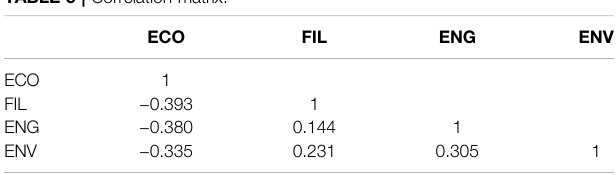
TABLE 5 | Correlation matrix.